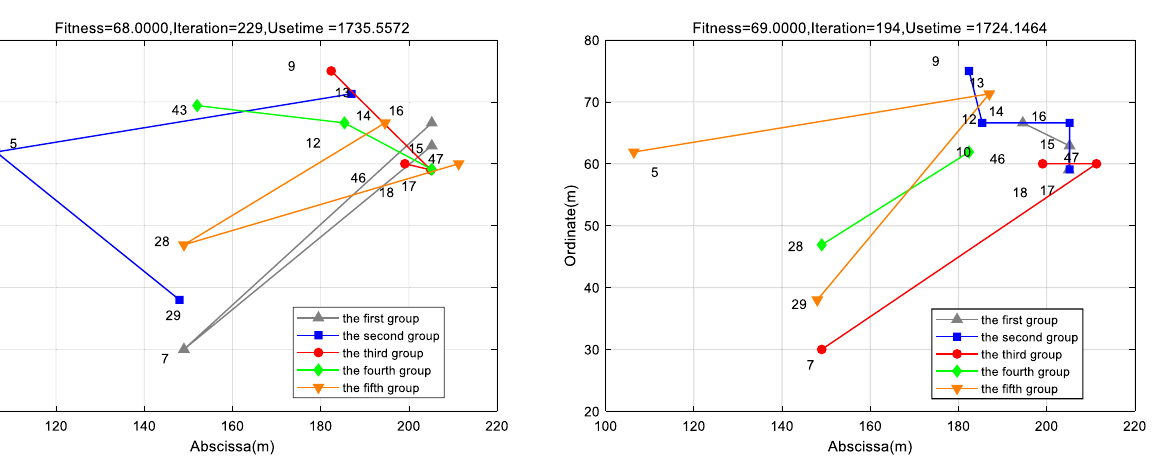
Fig. 10 Recovery strategy of improved genetic algorithm on quotient